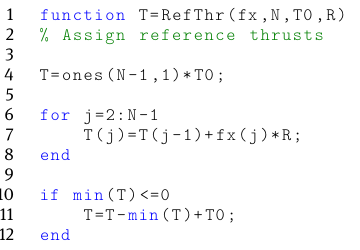
(Figure 7): the arch span S , rise H and thickness t ; its uni- tary weight F sw ; uniformly distributed load F u ; the height Y f and unitary weight of filling F f .